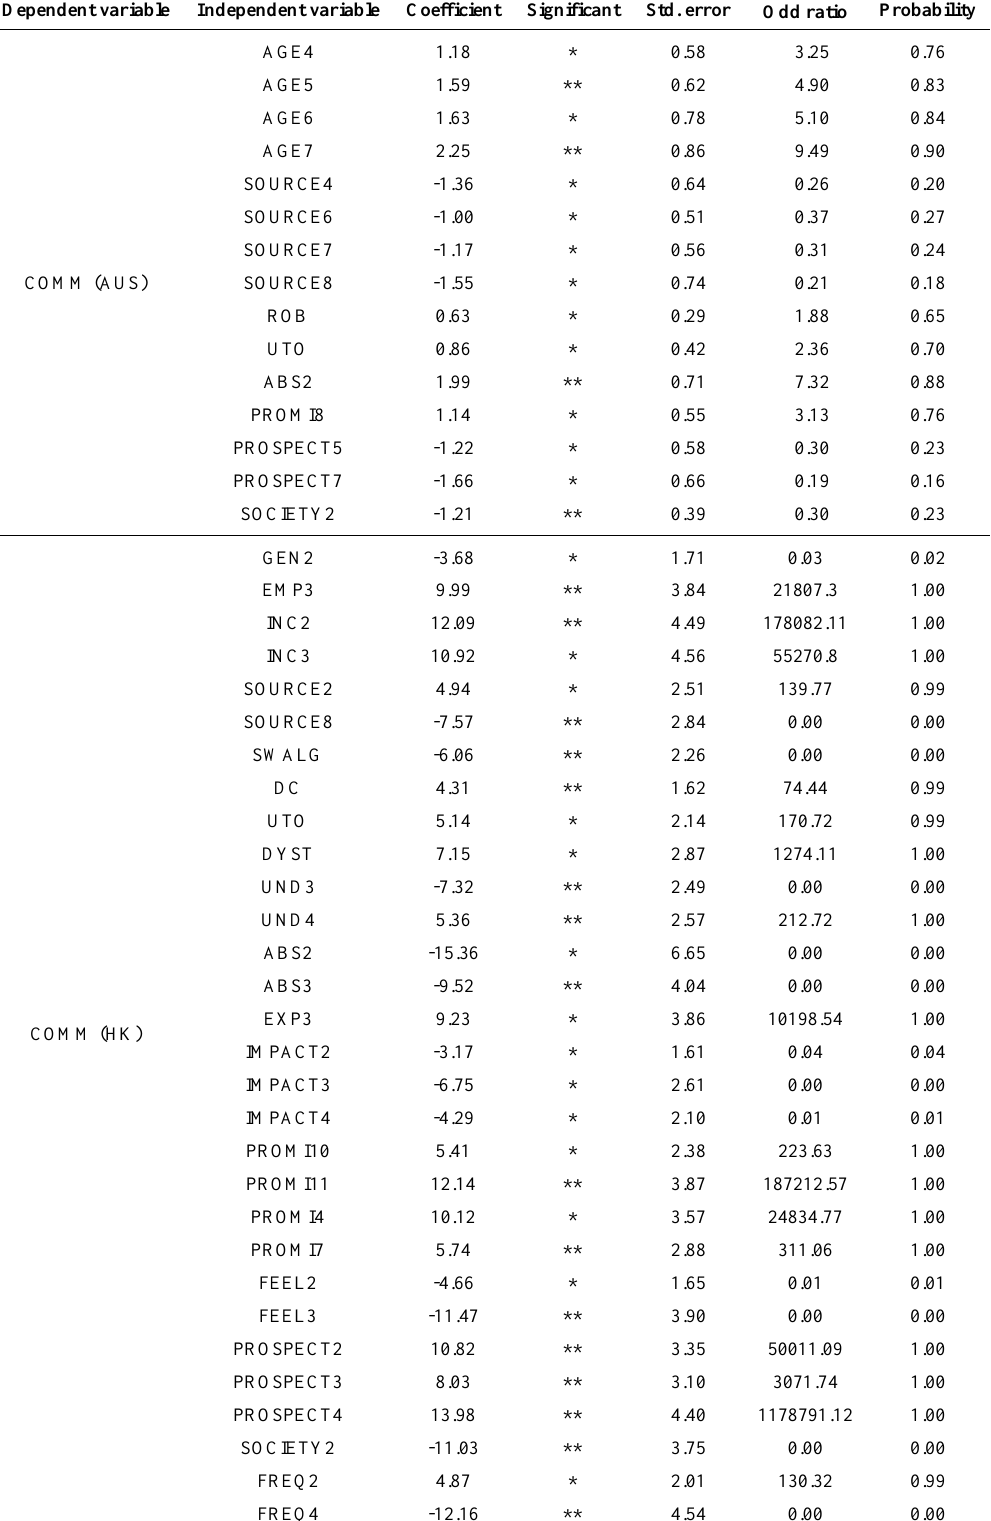
Table A-5. Community support and